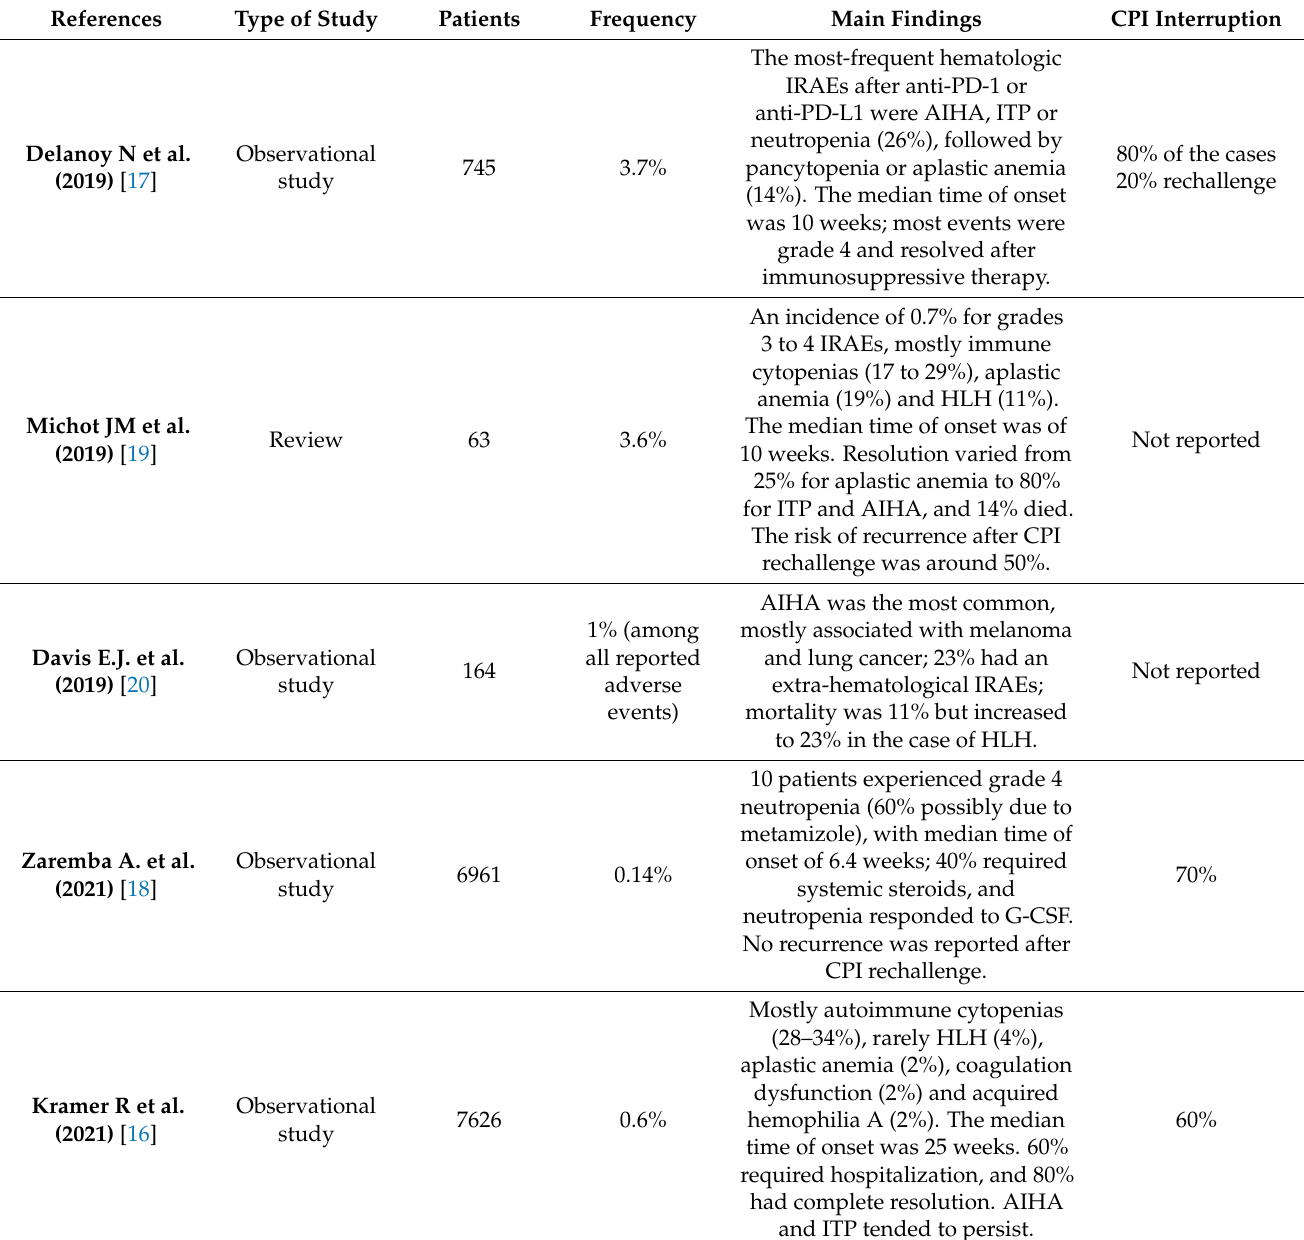
Table 1. Hematological toxicities after checkpoint inhibitors